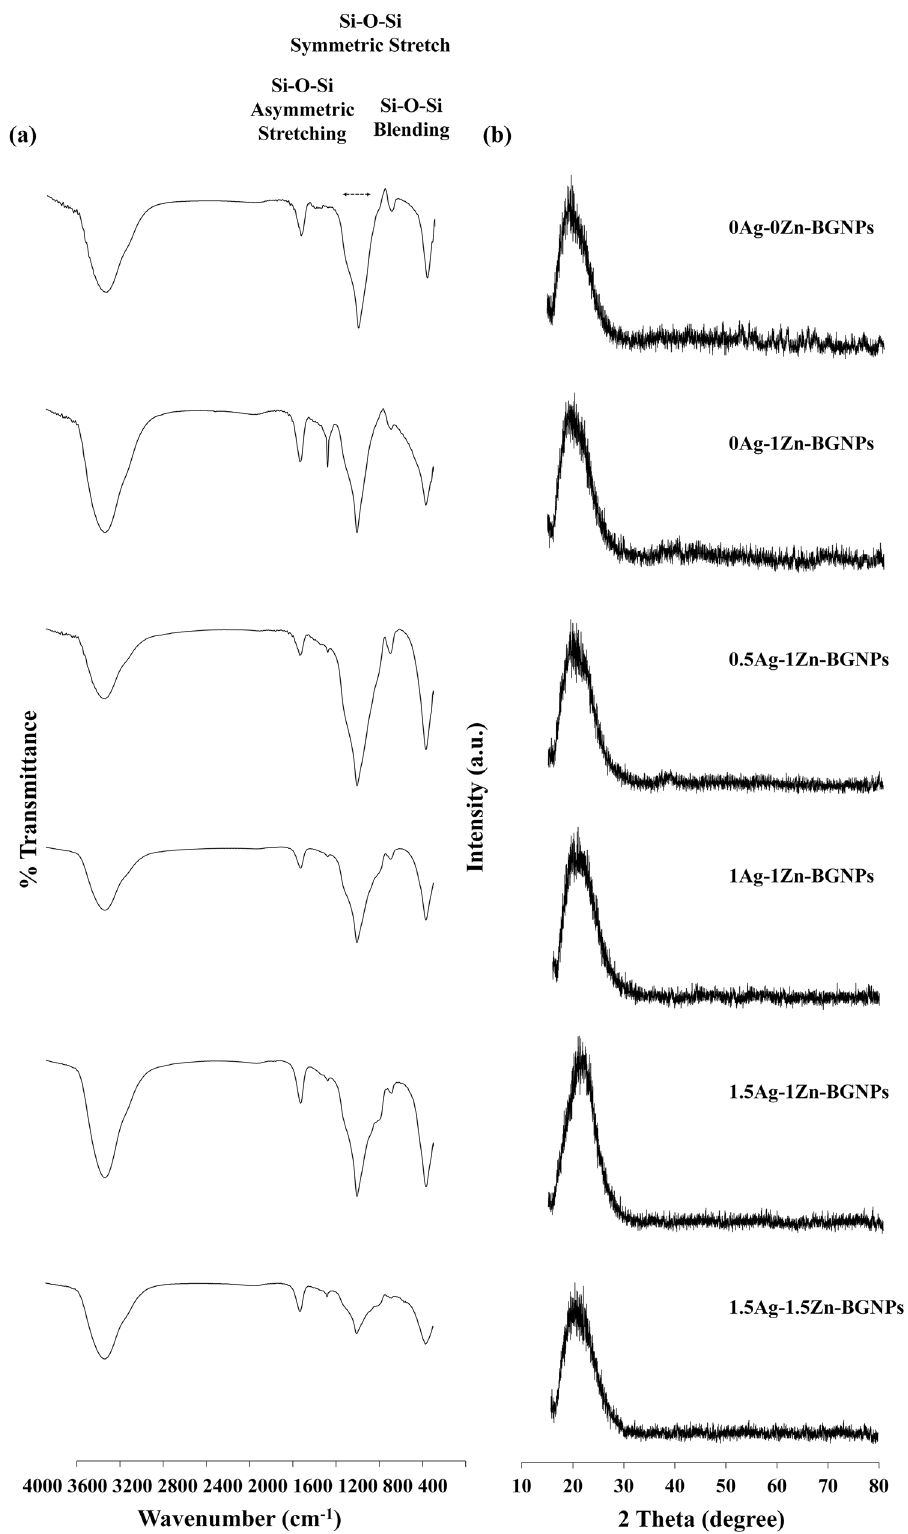
Figure 2. ( a ) FTIR spectra and ( b ) XRD spectra of